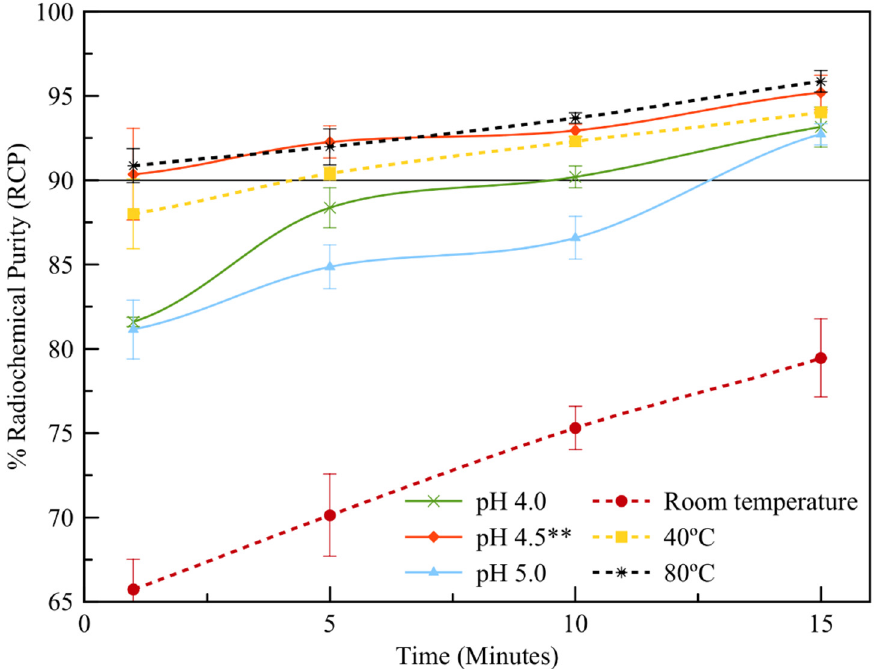
Figure 14. The optimization of %RCP at three different pH (constant temperature: 60 °C, NODPAM precursor: 4 nmol) and the temperature (constant pH 4.5, NODPAM precursor: 4 nmol) reacted in 500 µ Ci ± 10. ** reaction of 60 °C.